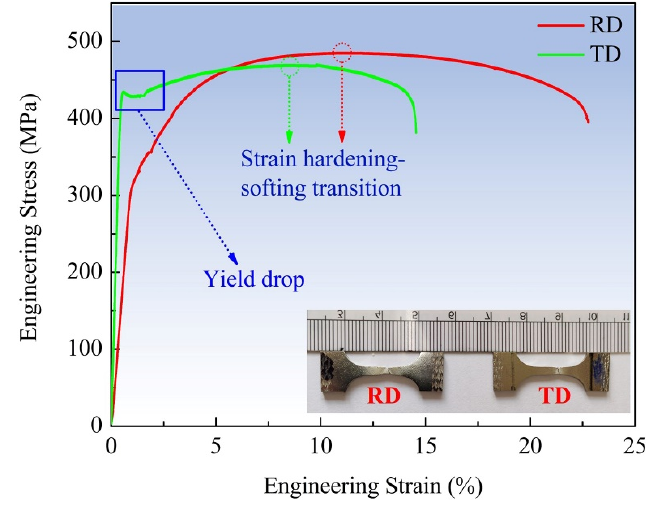
Figure 2. Engineering stress strain curves of Zircaloy-4 along the RD and TD.